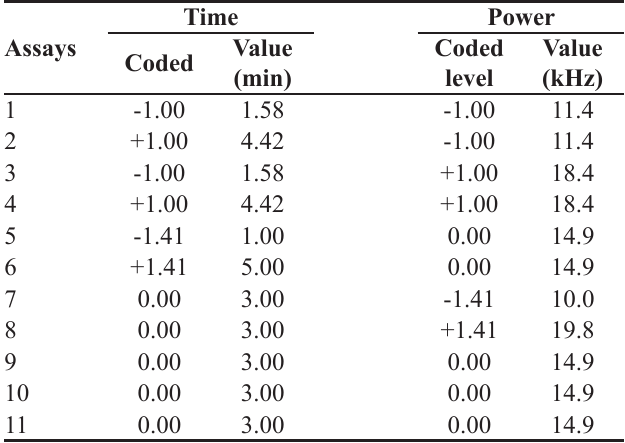
TABLE I - Coded levels and actual values of the variables time and sonication power